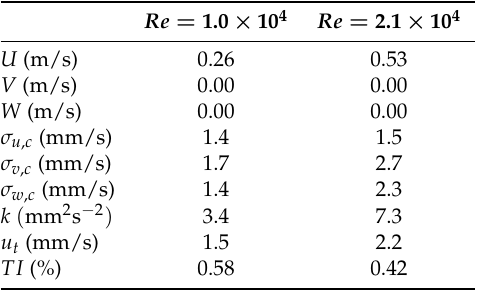
Table 3. Incident flow velocity